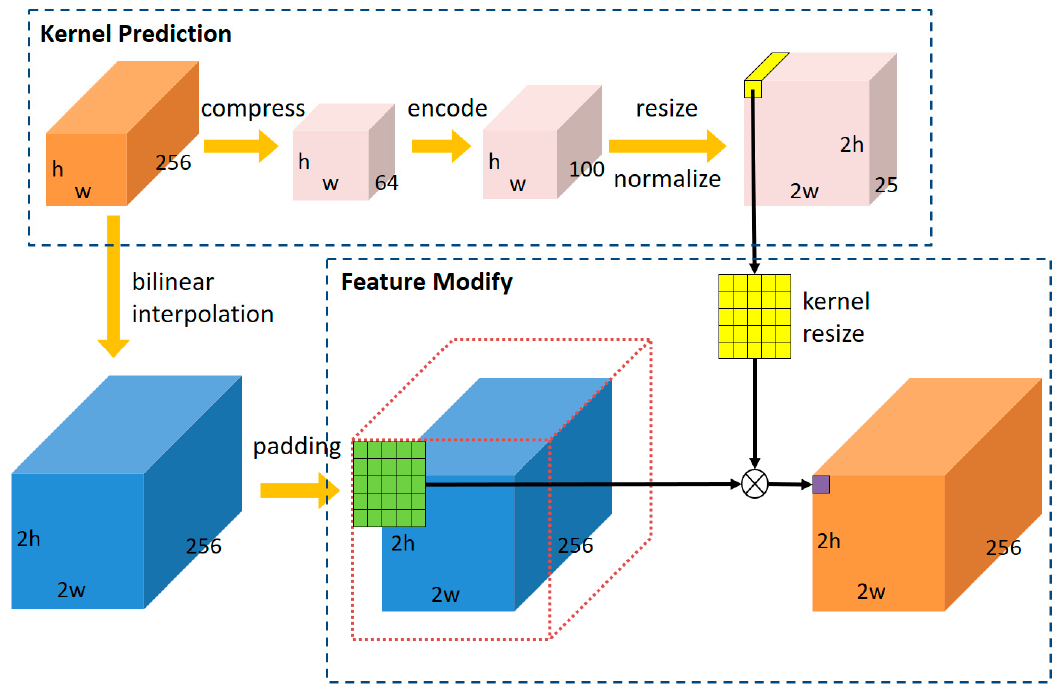
Figure 3. The structure of CAFUS. We chose a prediction kernel size of 5 × 5 and an up-sampling ratio of 2; therefore, the number of channels of the encoded feature map is 2 × 2 × 5 × 5 = 100. As for the choice of the number of compressed channels, we found that increasing the number of com- pressed channels does not have a significant improvement on the algorithm effect.